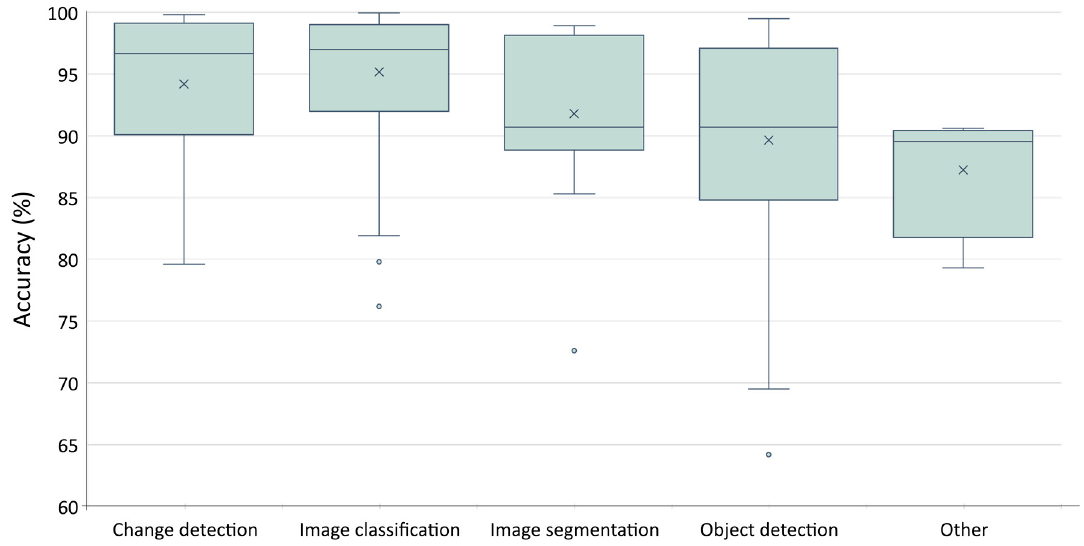
Figure 13. The produced accuracy of the developed At-DL methods for different tasks in the papers.